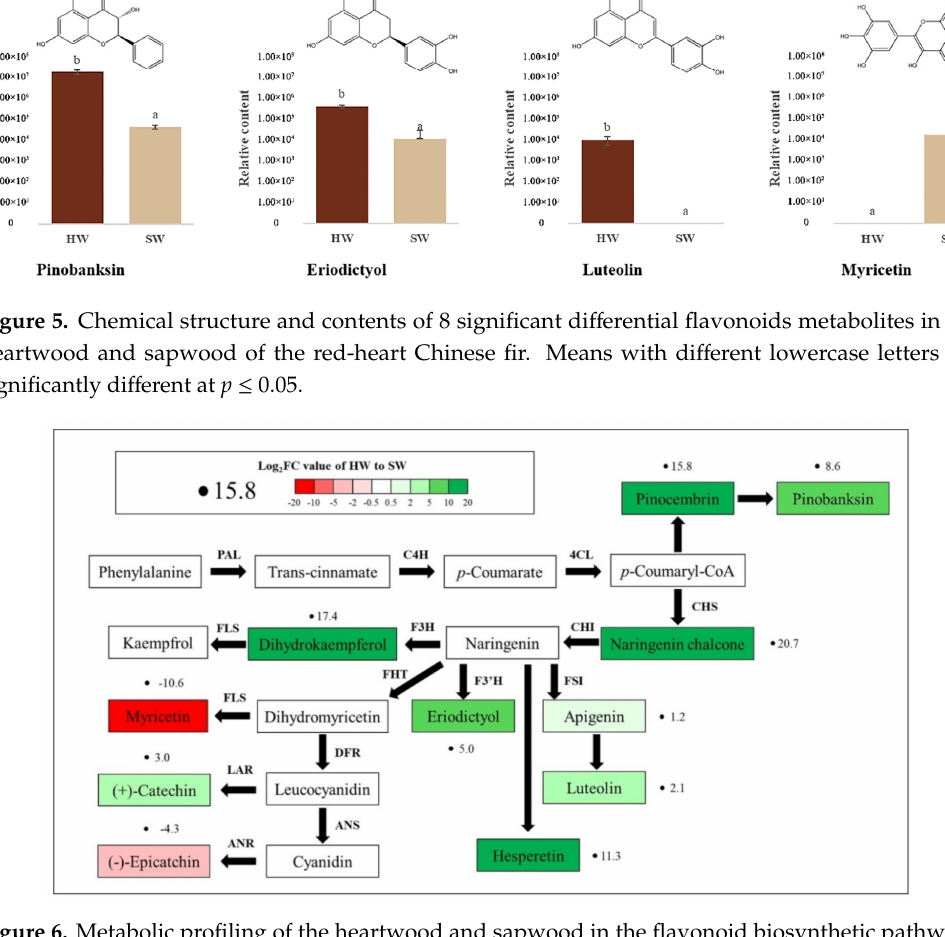
Figure 6. Metabolic profiling of the heartwood and sapwood in the flavonoid biosynthetic pathways in the red-heart Chinese fir. Grids with green and red color-scales from light to dark represent the Log 2 FC values of HW to SW 0.5–2, 2–5. 5–10, 10–20, and over 20, respectively. PAL,